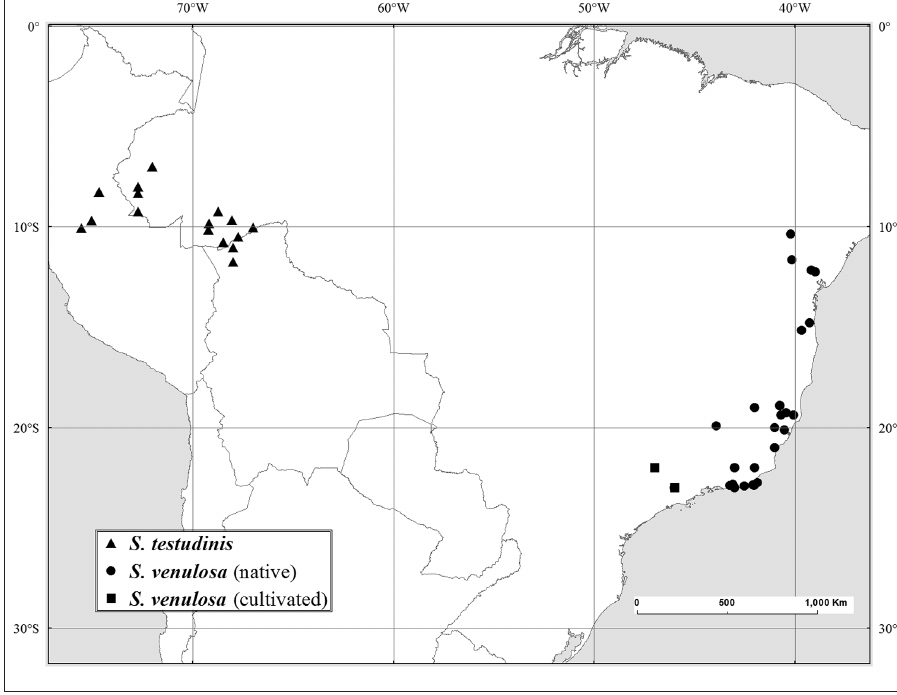
Figure 24. Distributions of Spondias testudinis and S.